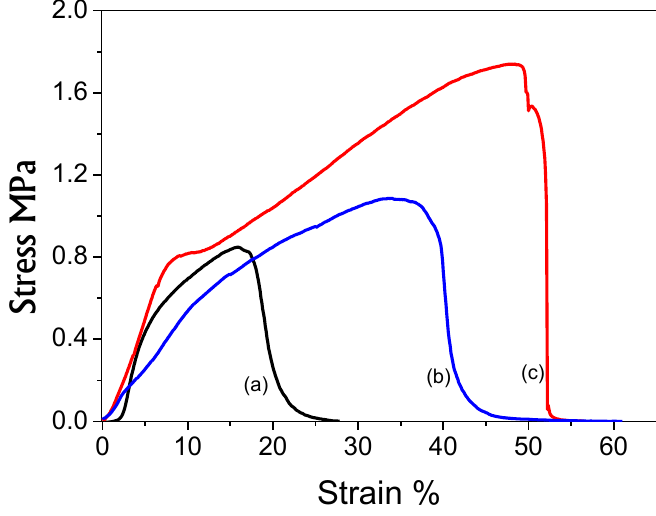
Figure 9. The tensile strength of PAN nanofibers: (a), one cycle loaded AgNPs to PAN nanofibers after 72 h washing: (b), and one cycle loaded AgNPs to PAN nanofibers: (c).